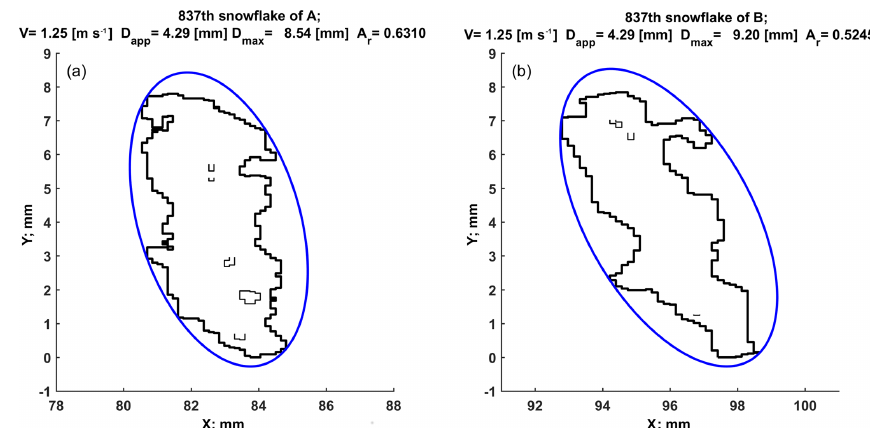
Figure 1. A snowflake observed by a 2DVD from two views. The thick black line is the contour of the snowflake and the thin black lines show the holes inside the snowflake. The effective area, A e , equals the area enclosed by the thick black curve minus the area enclosed by thin lines. The blue line represents the minimum circumscribed ellipse, the enclosed area of which is denoted by A .